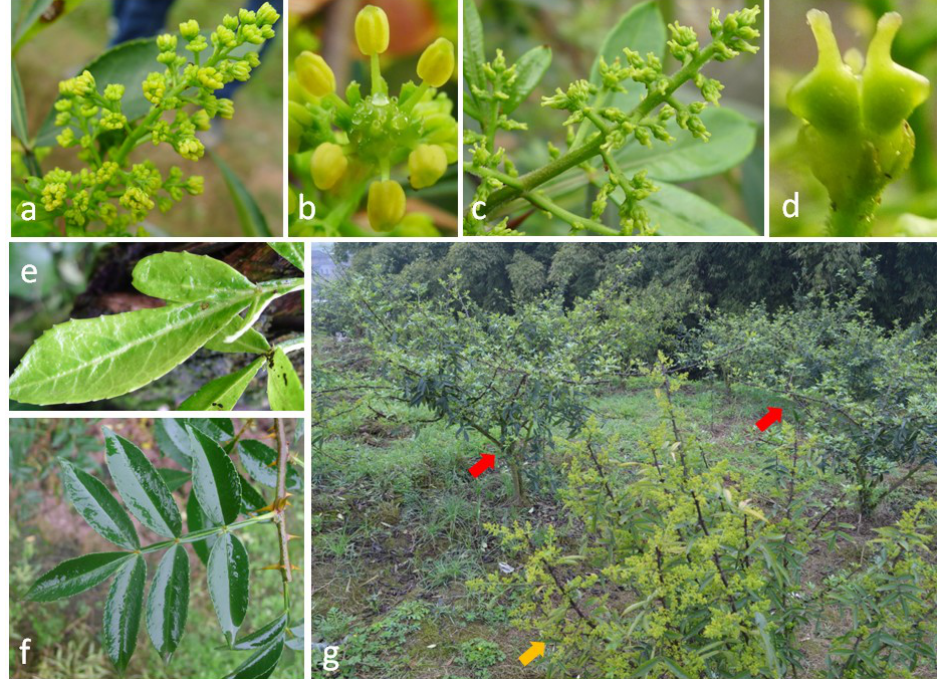
Figure 1. ( a, b and e ) Green Sichuan pepper plant infected with flower yellowing disease (FYD) Figure 1. ( a , b , e ) Green Sichuan pepper plant infected with flower yellowing disease (FYD) exhibiting exhibiting yellowing and tumescent stamen, and yellowing and small leaf. ( c, d and f ) Normal yellowing and tumescent stamen, and yellowing and small leaf. ( c , d , f ) Normal stamen and leaf of stamen and leaf of healthy plant. ( g ) The FYD-affected tree (yellow arrow) among asymptomatic healthy plant. ( g ) The FYD-a ff ected tree (yellow arrow) among asymptomatic trees (red trees (red arrows).